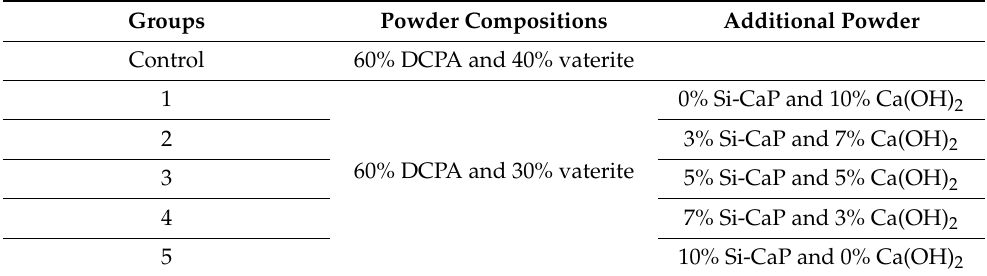
Table 1. The powder composition specimens. Groups Powder